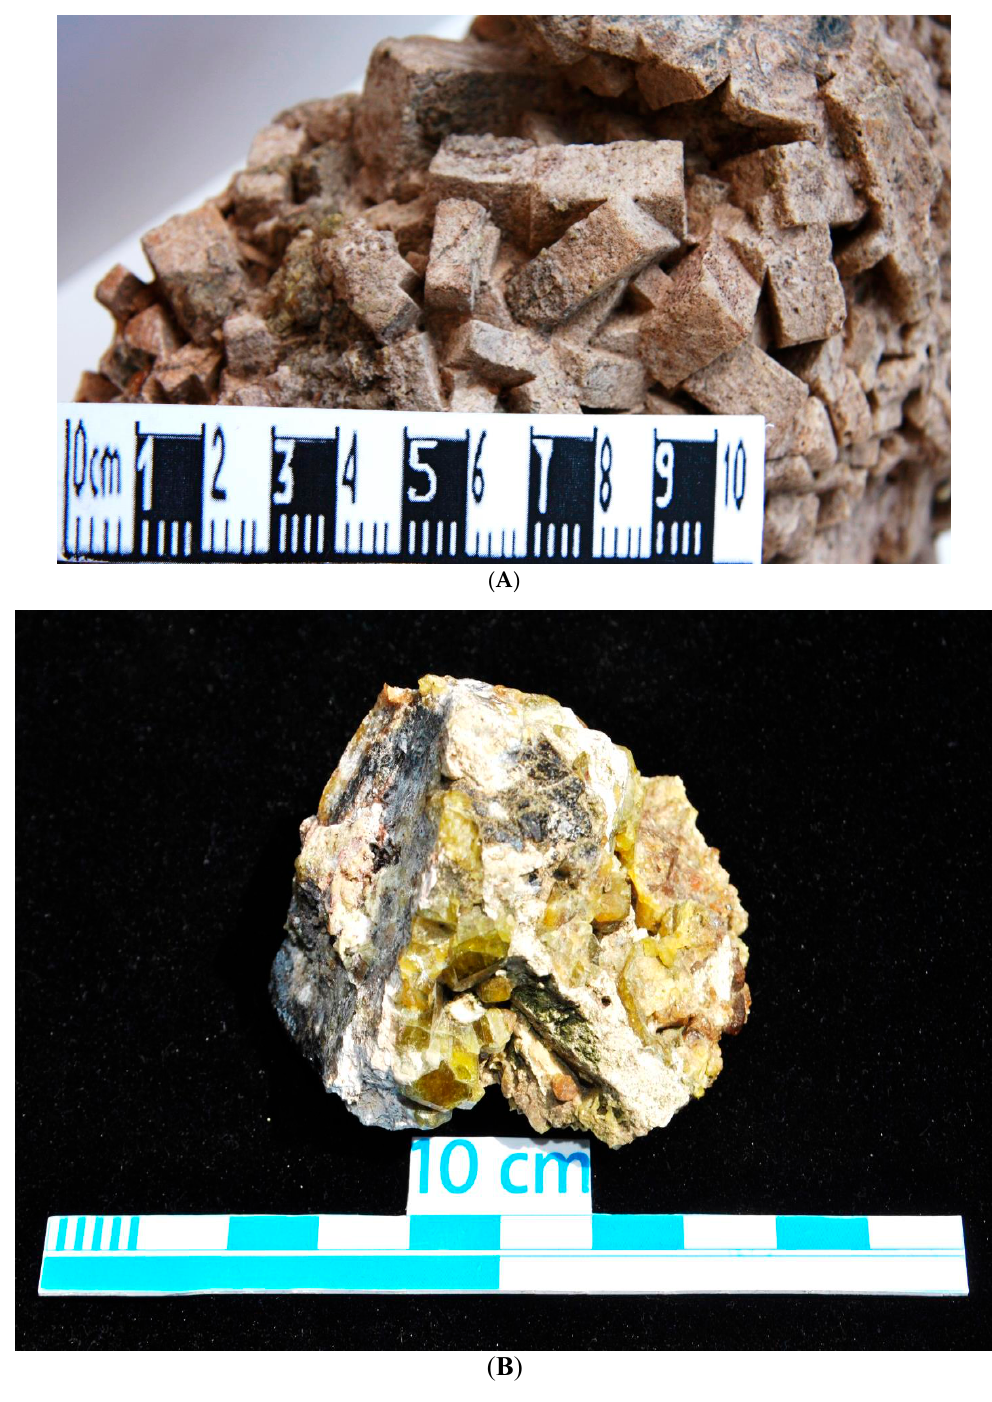
Figure 3. Macrophotographs of a specimen of blocky gehlenite from M ă gureaua Va ţ ei with recognizable tetragonal prism {100} and pinacoid {001} forms ( A ) and of a hand specimen of skarn with vesuvianite crystals showing tetragonal pyramid and basal pinacoid forms ( B ).